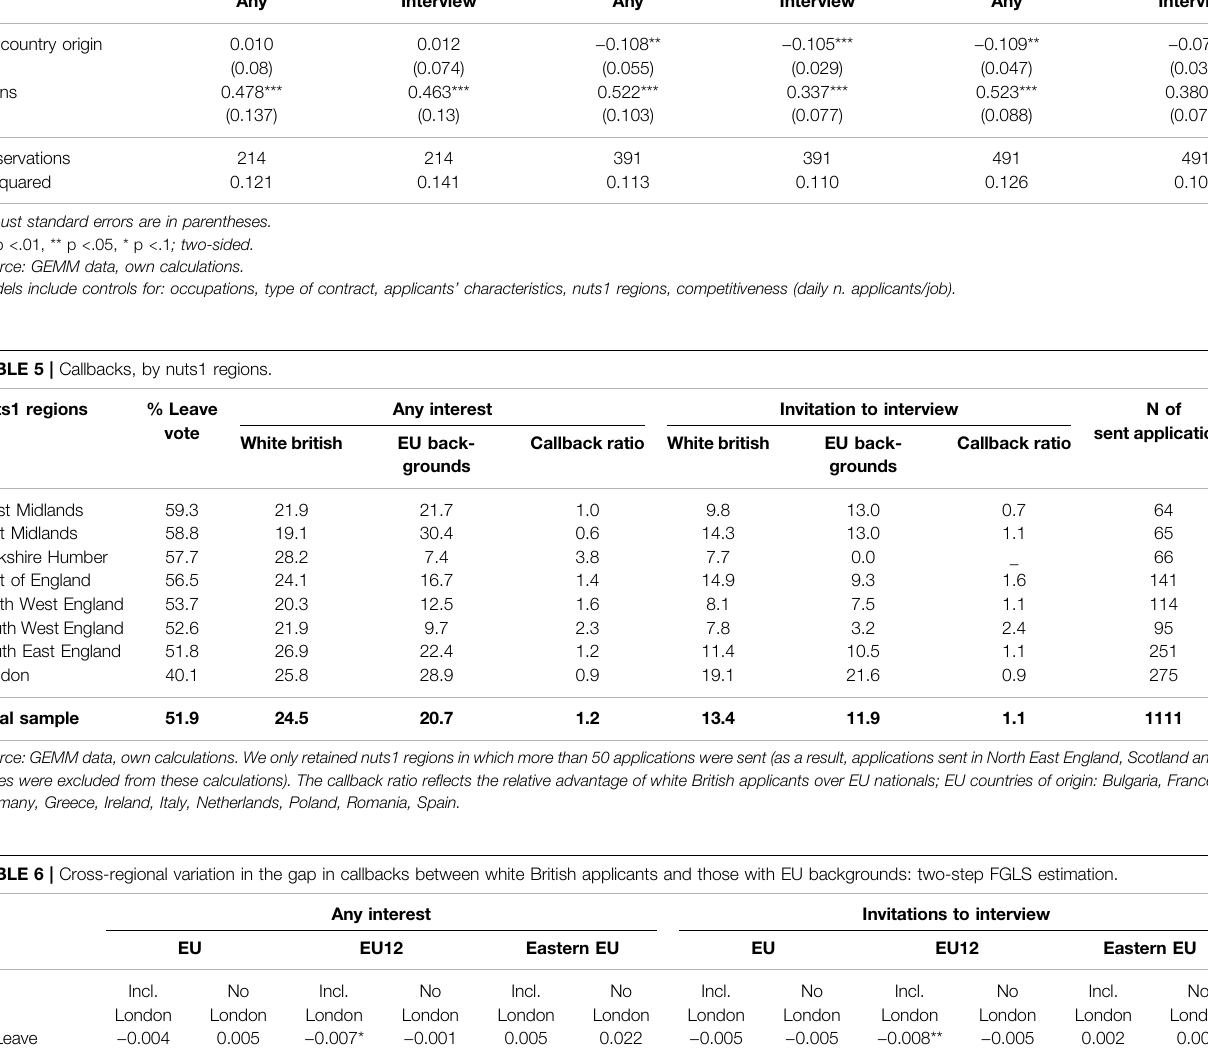
TABLE 4 | Discrimination against applicants with EU backgrounds, by post-Brexit semester. M1: 1 st semester M2: 2 nd semester M3: 3 rd semester Any Interview Any Interview Any Interview EU-country origin